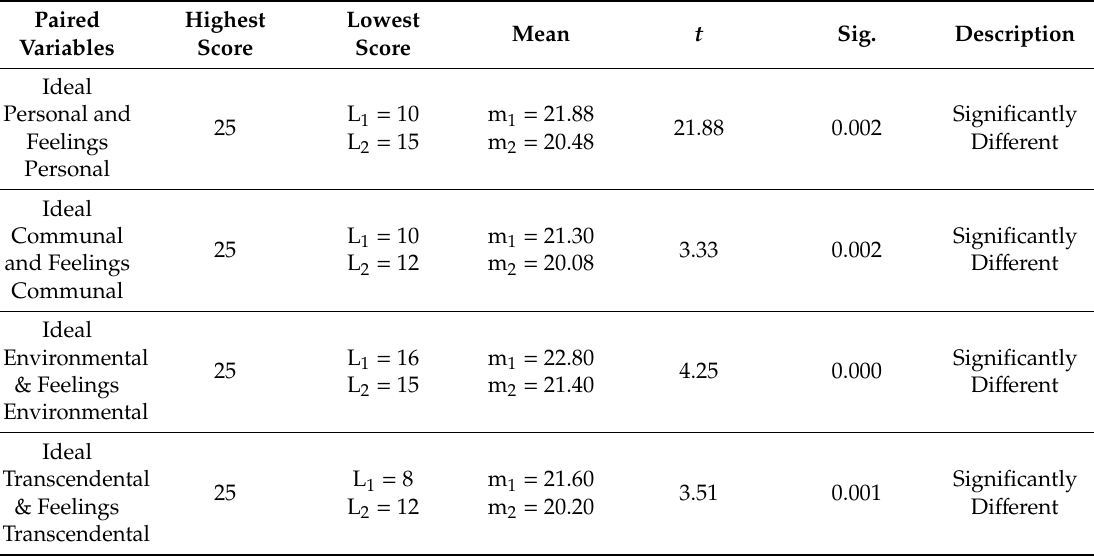
Table 4. Results of comparison between ideals and